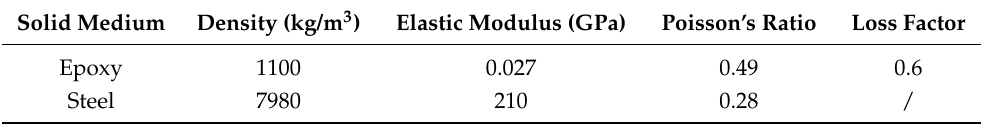
Table 2. Material parameters “Adapted with permission from Ref. [26]. 2020, Elsevier Ltd.”.